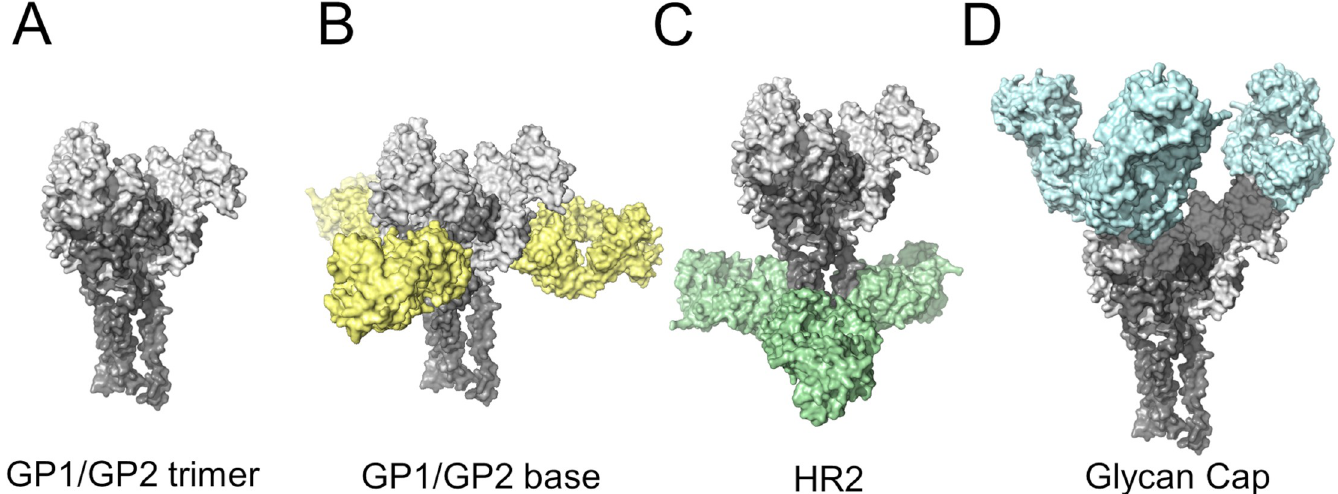
Fig 6. Main regions of the EBOV GP trimer for Ab recognition. (A) Structural model of the EBOV GP trimer recognized by anti-EBOV Abs. Abs have been colored according to the regions of the trimer that they bind, i.e., B) base of the trimer, C) the α -helical heptad repeat 2 (HR2) region, and D) the glycan Cap domains.